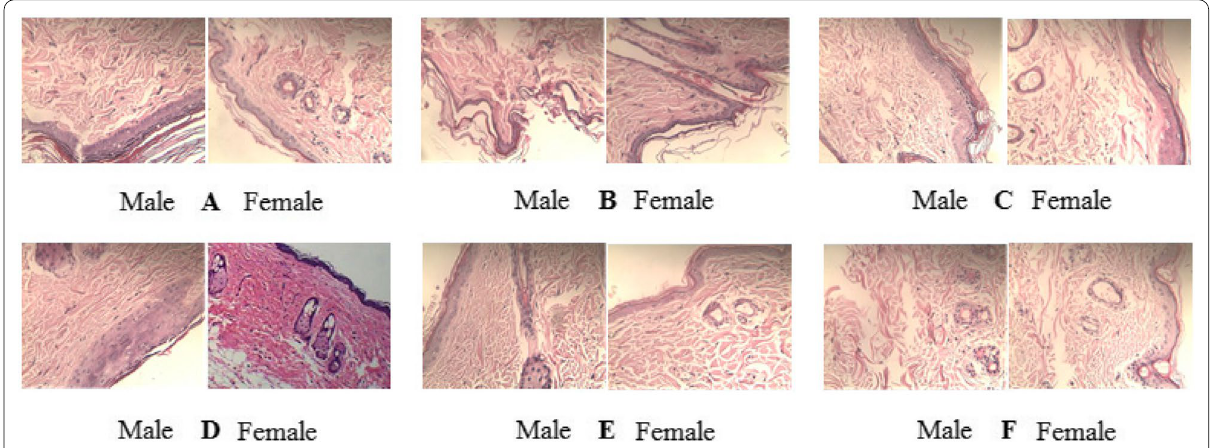
Fig. 4 Histology of skin tissue section. A Control, normal skin, B photoaging model, C treatment with vitamin D3 solution, D treatment with vitamin D3 liposomes, E treatment with aloe gel as positive control, F treatment with PBS. H&E 200x